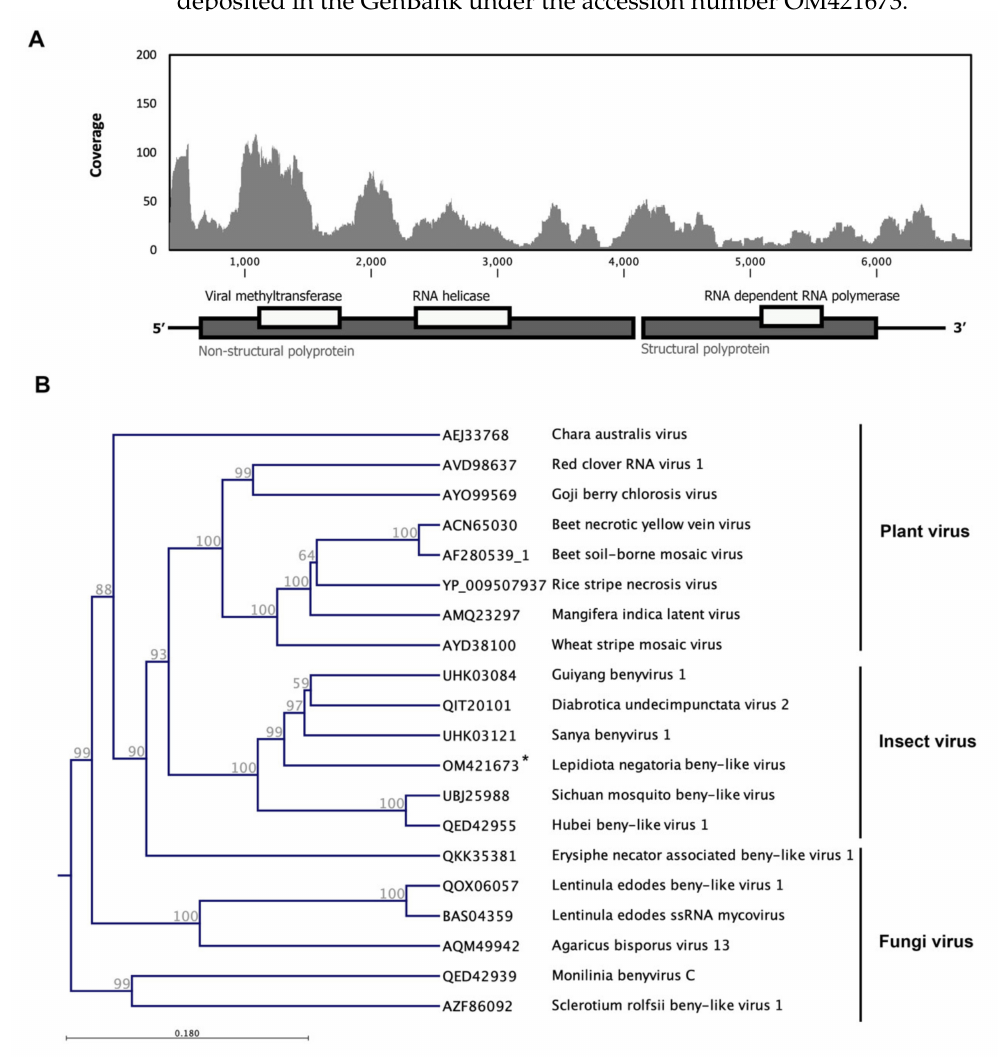
Figure 6. Schematic of the genome organization and coverage of Lepidiota negatoria beny-like virus (LnBV). RNA-Seq read density plotted along the viral genome. The Y -axis shows the number of reads mapped to a particular nucleotide of the virus genome at X -axis. Only 1350 reads mapped to this draft genome sequence ( A ). The maximum likelihood phylogeny classified this novel virus with other insect-specific, beny-like viruses and separated them from plant and fungi viruses. The identified virus in this study is shown with an asterisk ( B